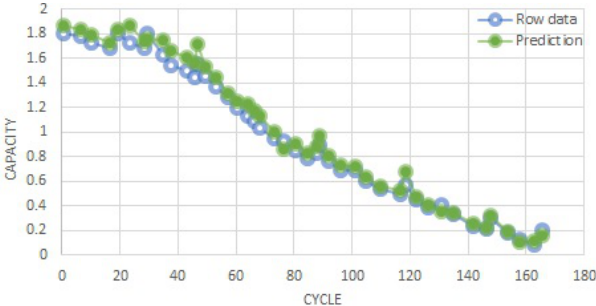
Figure 10. RUL estimation